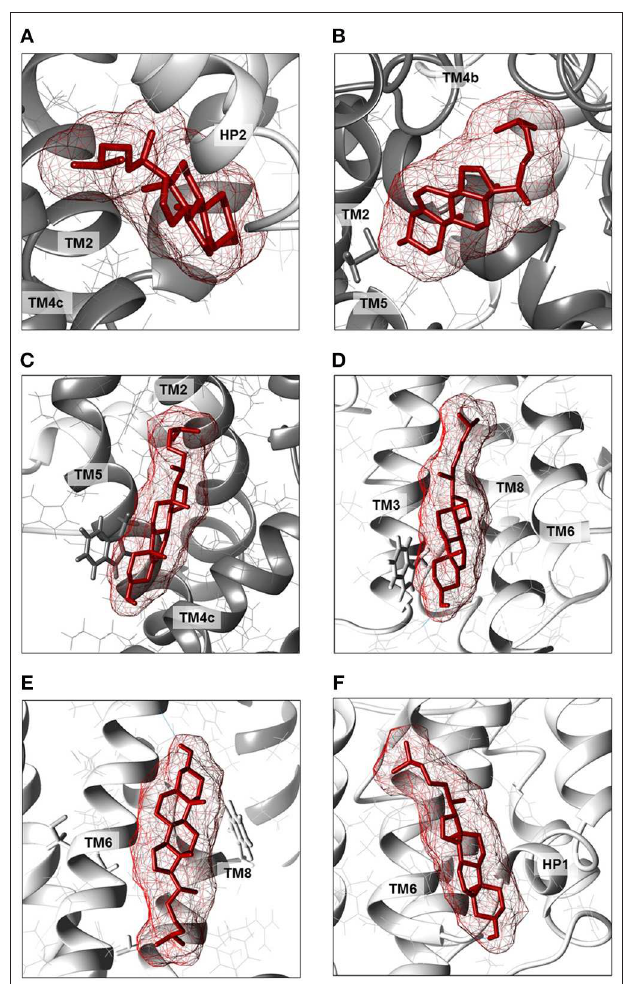
FIGURE 6 | Enlargements of cholesterol poses. Cholesterol molecules are depicted as red sticks with mesh surface facing to residues of neighboring helices in scaffold domain (dark gray ribbon) or transport domain (light gray ribbon). (A) Cholesterol facing to TMs 2, 4c (scaffold domain) and HP2 (transport domain) of a protomer. (B) Cholesterol facing to TMs 2, 4b and 5 (scaffold domain) of two protomers; in gray stick, residue C110. (C) Cholesterol facing to TM4c (scaffold domain) of a protomer and TM2 and TM5 (scaffold domain) of the adjacent protomer; in gray stick, residue W272. (D) Cholesterol facing to TMs 3, 6 and 8 (transport domain) of a protomer; in gray stick, residue W130. (E) Cholesterol facing to TM6 (transport domain) including CARC motif and TM8 (transport domain); in gray stick, residues C308 and C309 (TM6) and W461 and C467 (TM8). (F) Cholesterol facing to TM6 (transport domain) including CRAC motif and HP1 (transport domain) of a protomer. Except those indicated in gray stick, all residues are indicated as gray wire. The structure was visualized using Chimera 1.13.1